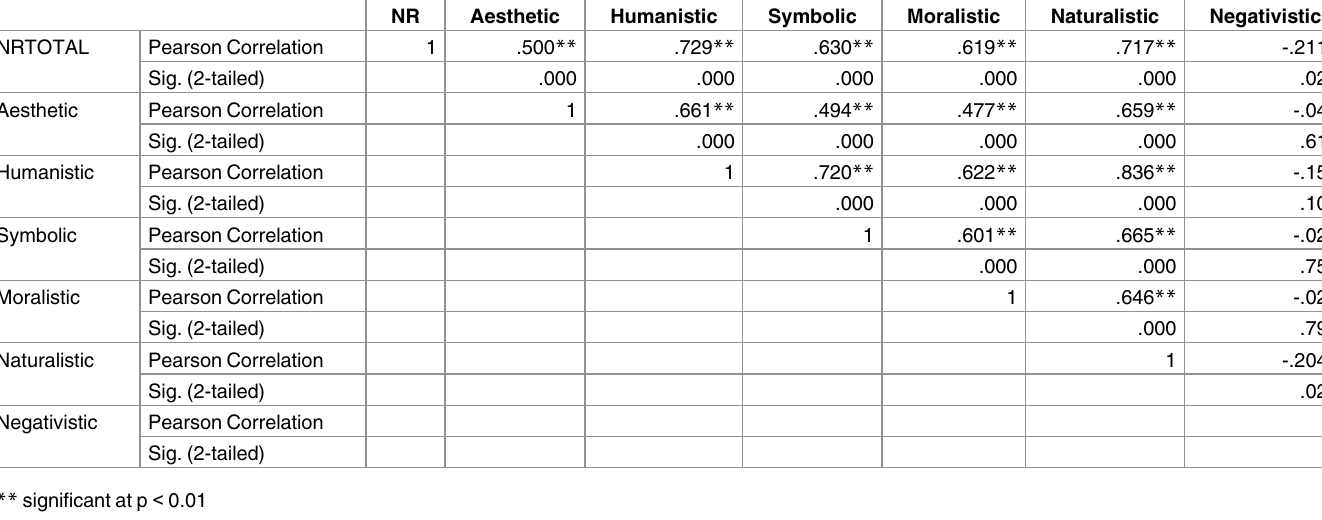
Table 10. Inter-Correlations between engaging with the six biophilic values (N = 118).